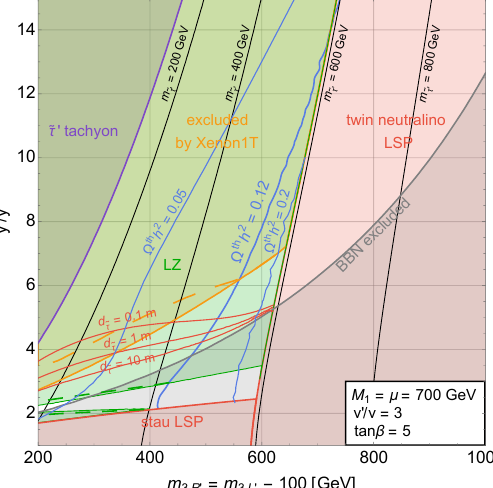
Figure 6. Contours of Ω th h 2 (blue lines) and the twin stau LSP mass (black line) in the plane ( m 0 /y τ ). The remaining parameters are set to m 3 L = m 3 R + 100 GeV, tan β = 3 , µ = M 1 = 3 R , y τ 700 GeV, M = 10 TeV, and v 0 /v = 3 . The color coding of various regions is the same as in figure 2